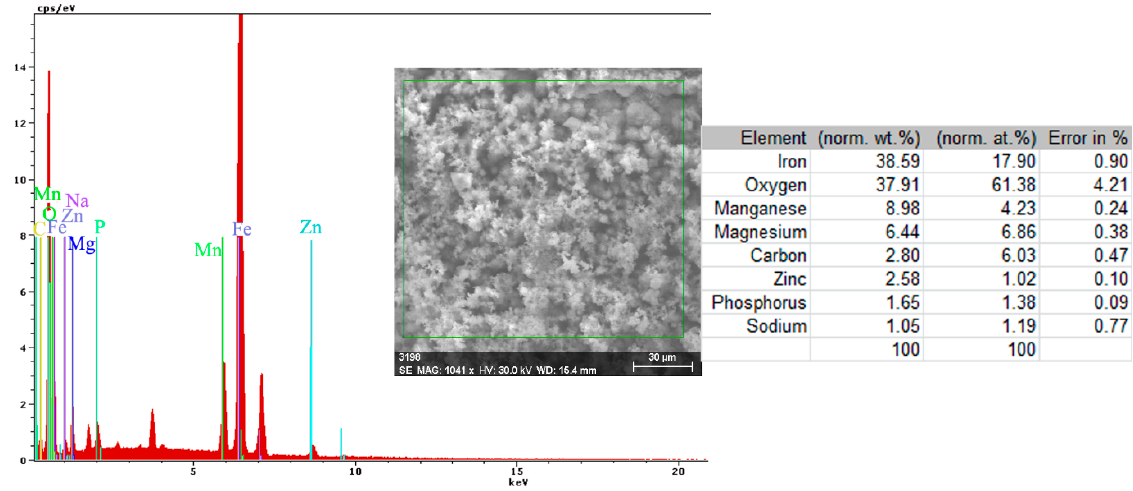
Figure 12. Energy spectrum and surface composition of the crust in the A zone of the PS sample maintained for 85 days in BSW.